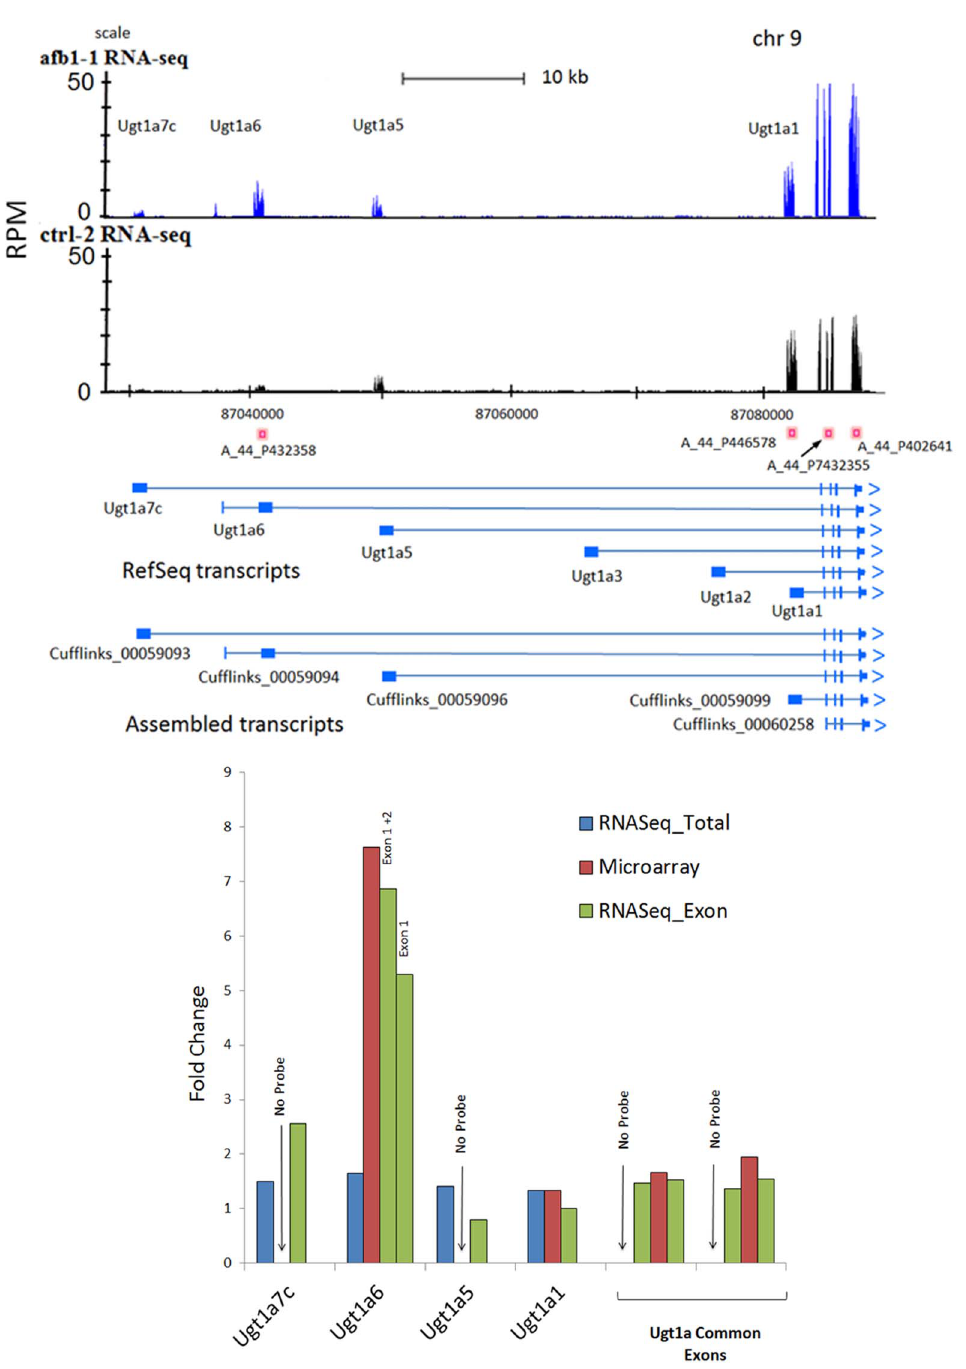
Figure 6. Exon specific expression among homologous transcripts in the Ugt1a gene family. Panel A. The genomic region for Ugt1a transcripts is displayed on the X-axis in UCSC browser format where the Y-axis represents mapped reads in RPM units. Placements of microarray probes for specific transcripts are indicated by rose-colored boxes with probe names below. There are a total of four microarray probes, some of which correspond to shared exons of the Ugta1 gene family (A_44_P432355, A_44_P402641) or to specific exons defining Ugt1a1 (A_44_P446578) and Ugt1a6 (A_44_P432358) isoforms. RefSeq transcripts and Cufflinks assembled transcripts are displayed under the RNA-Seq tracks. Exons are shown as light blue blocks or bands; introns are lines between exons; arrows at the end of each transcript indicate direction of transcription. Panel B. Bar graph shows mean fold changes (AFB1/Control) on the Y axis for the entire RNA-Seq transcript (blue), the microarray probe (red) and the isoform- specific RNA-Seq_exon (green). For some exons, there was no corresponding microarray probe 2 ‘No Probe’ (e.g. Ugt1a5, Ugta1a7c). Exon-specific, RNA-Seq ratios were labeled by exon number. Ugt1a-Common consists of four exons (common to all Ugt1a isoforms) for which two microarray probes exist. Exon-specific ratios from RNA-Seq reads were calculated for Exons 1, 2, 3 and 4. RNA-Seq exon-specific reads were measured to calculate AFB1/Control ratios for Ugt1a1, Utgt1a5, both exons of Ugt1a6, and Ugt1a7c.